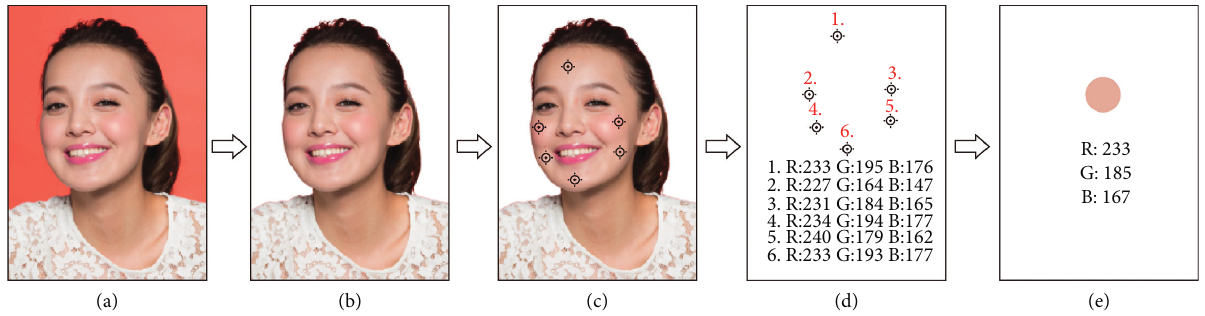
Figure 6: The traditional procedure to capture skin colour.